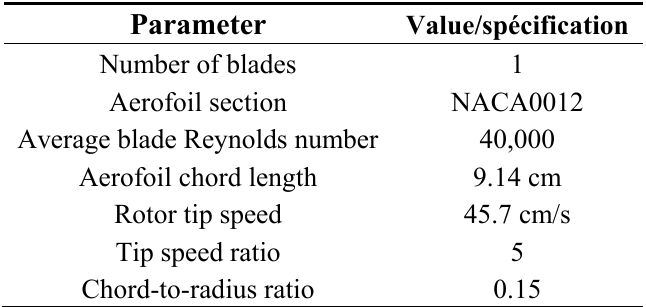
Table 3. Blade’s simulation